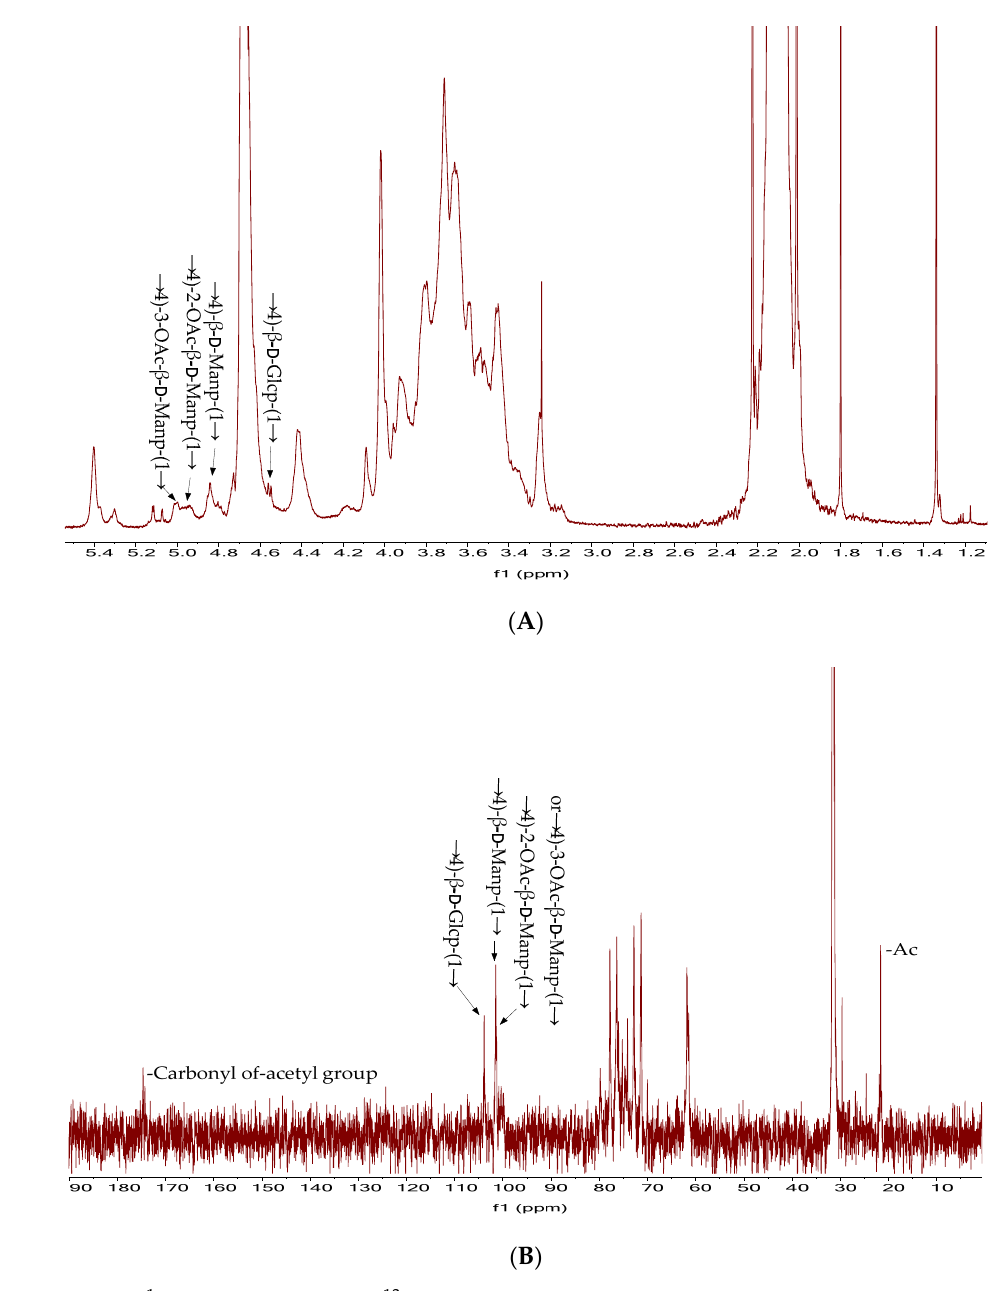
Figure 4. 1 H NMR spectrum ( A ); 13 C NMR spectrum ( B ).